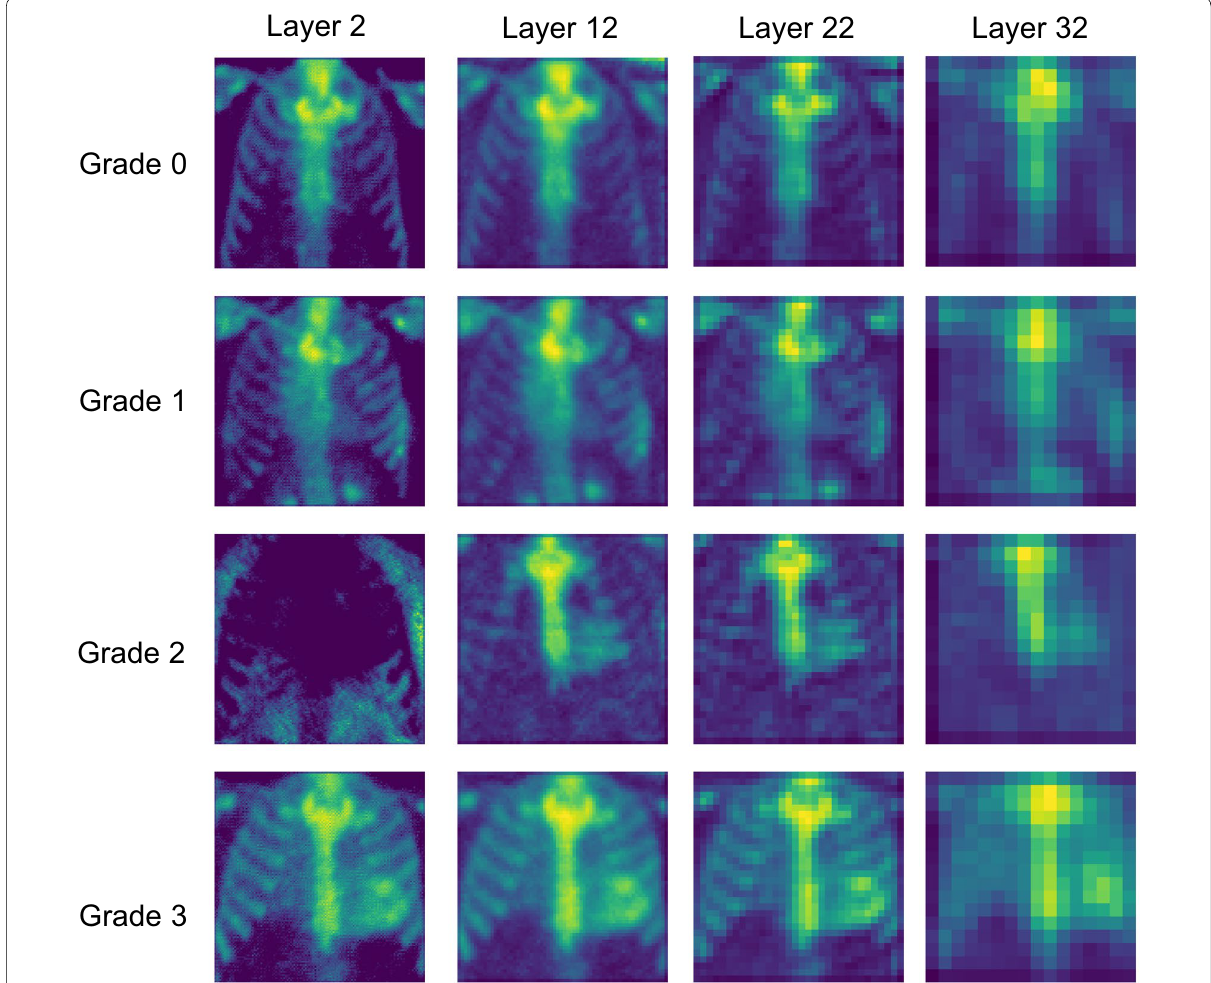
Fig. 5 Maximum activation maps for layers 2, 12, 22 and 32 of the Residual model for input images representing different grades of cardiac uptake. Activation maps demonstrate that the convolutional neural network model finds abnormal myocardial signal in patients with cardiac uptake suggestive for ATTR similarly to physician and not extracardiac features similarly to standard clinical reading by